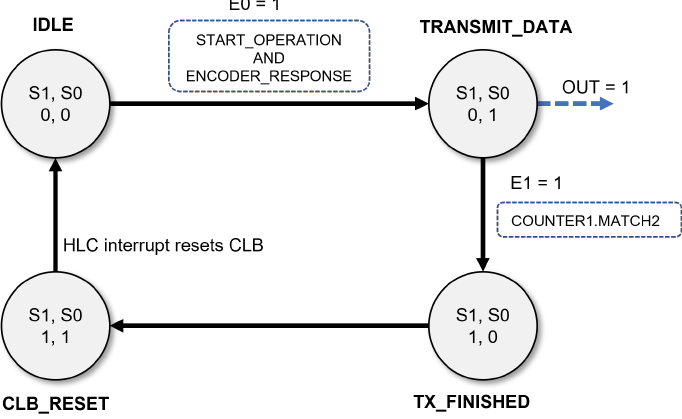
Figure 10. State diagram of